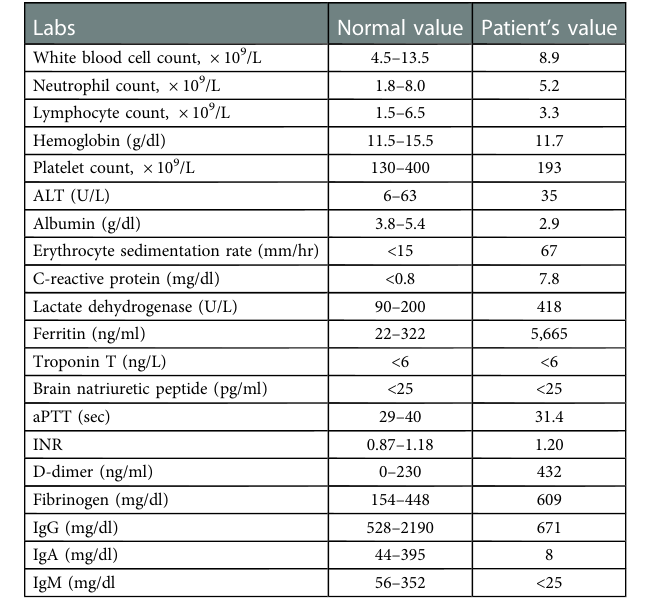
TABLE 2 Laboratory fi ndings at the time of presentation.